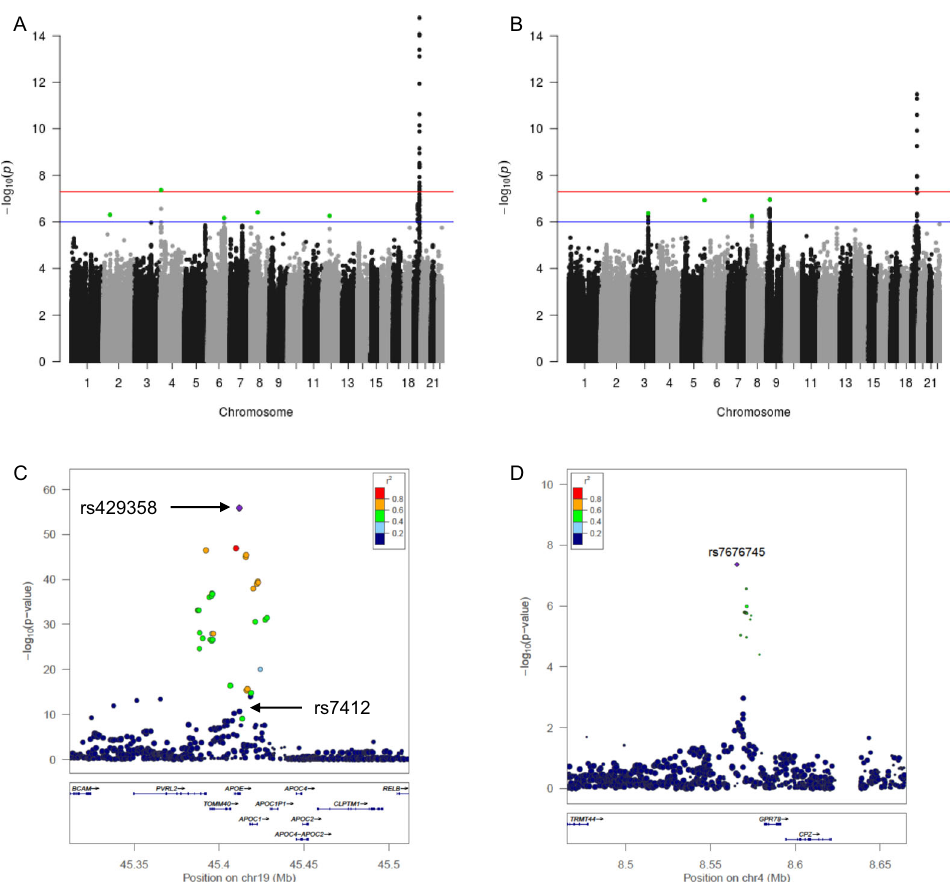
Fig. 1 Results of the European genome-wide association meta-analyses. Manhattan plot presenting the – log 10 P -values from the European genome-wide association meta-analysis of the 90th percentile cases versus all controls ( a ) and 99th percentile cases versus all controls ( b ). The red line indicates the threshold for genome-wide signi fi cance ( P ≤ 5 × 10 − 8 ), while the blue line indicates the threshold for genetic variants that showed a suggestive signi fi cant association ( P ≤ 1 × 10 − 6 ). The variants that are reported in Table 2 are highlighted in green. For representation purposes, the maximum of the y -axis was set to 14. Regional association plot for the APOE ( c ) and GPR78 ( d ) loci based on the results from the 90th percentile cases versus all controls meta- analysis. The colour of the variants is based on the linkage disequilibrium with rs429358 (ApoE ε 4) ( c ) or rs7676745 ( d